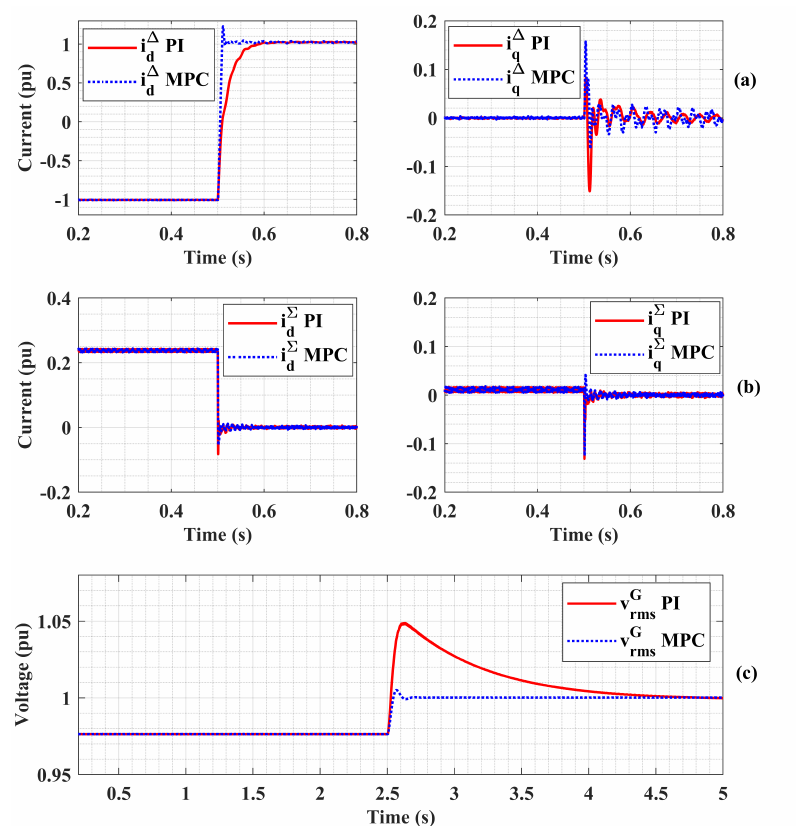
Figure 22. Comparison of PI and MPC controller during: ( a ) active power reversal; ( b ) circulating current suppression; and ( c ) AC voltage